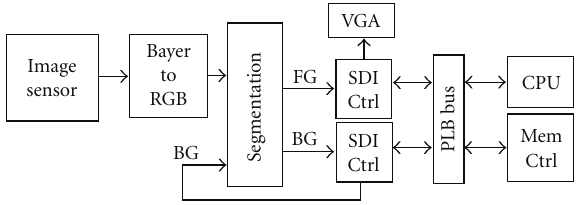
Figure 5: The hardware accelerated segmentation